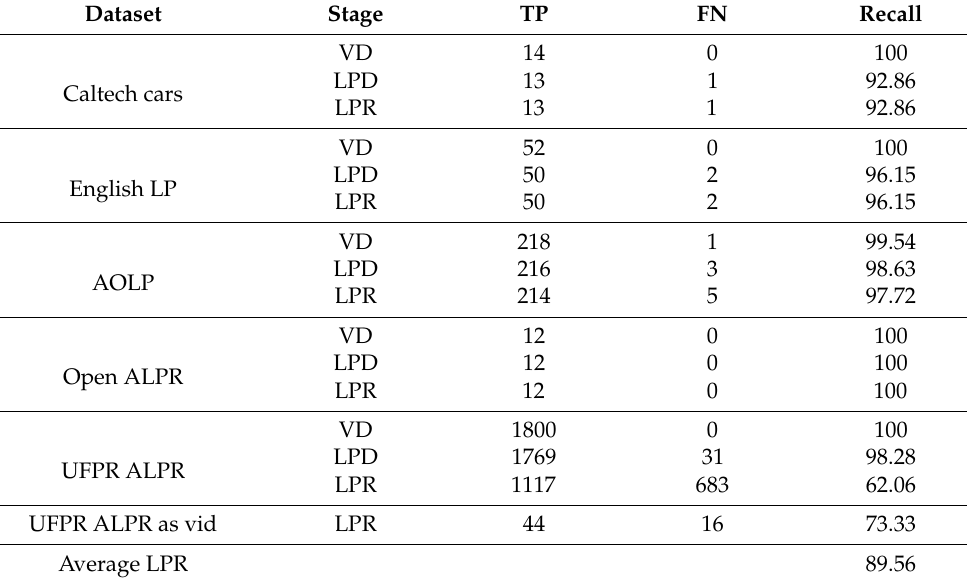
Table 9. Full ALPR pipeline results. Please note these results are chosen from one of the five test sets just to include the exact TP and FN to demonstrate how significant just one incorrect sample in the relatively small test sets can be in some datasets. All the other test sets had very similar results.